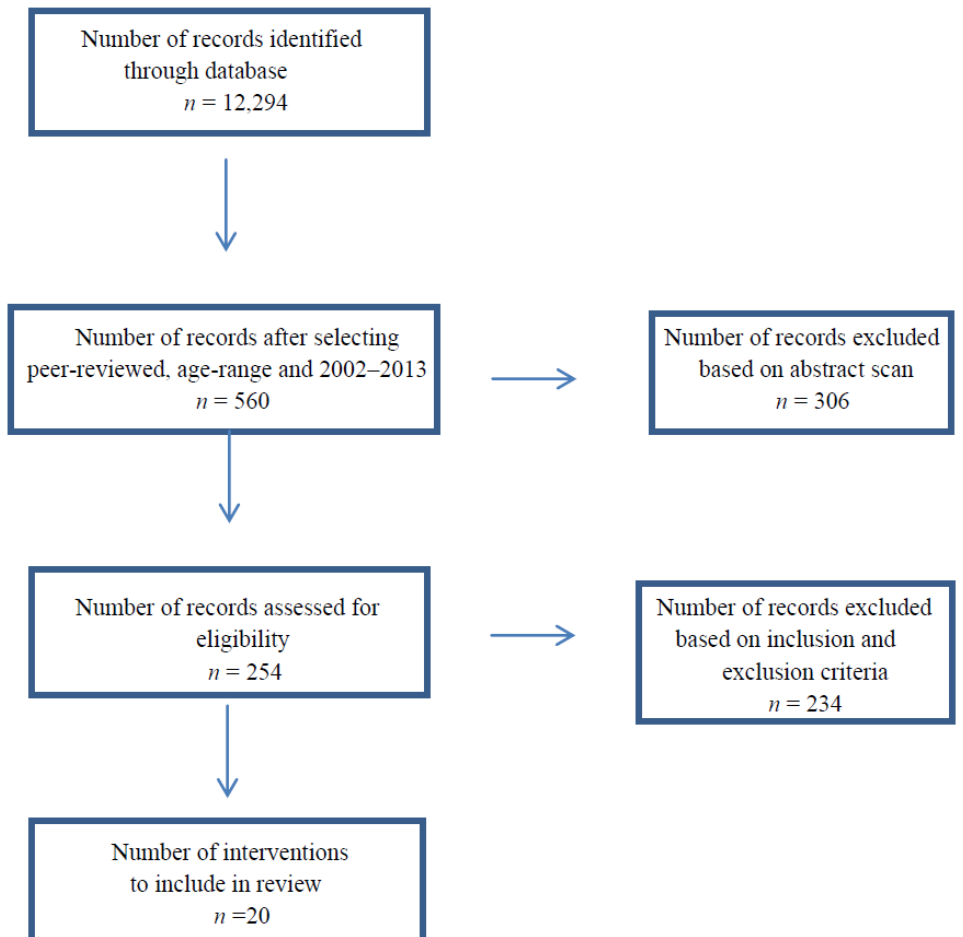
Figure 1. A summary of search